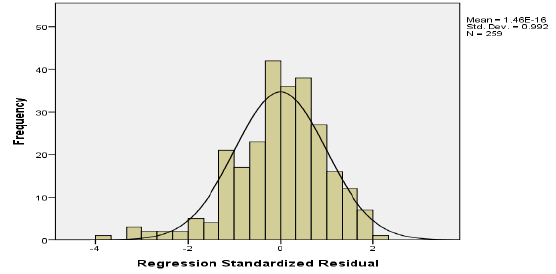
Fig. 2 . Histogram – Dependent Variable: Financial